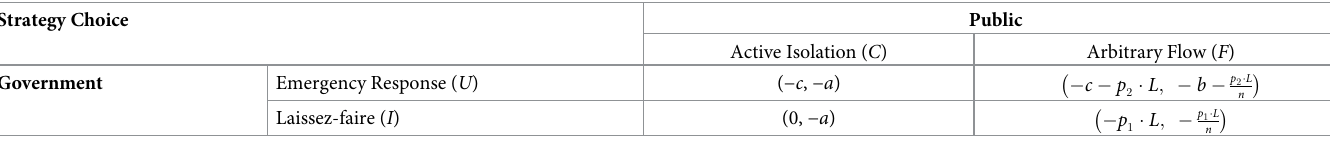
Table 1. The game matrix between the government and the public in major public health emergencies. Strategy